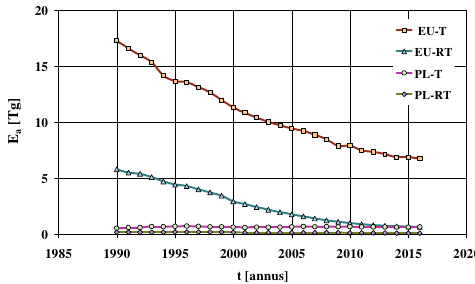
Fig. 5. Annual emission of particulate matter PM10: total in the Europe- an Union – EU-T, from motor vehicles in the European Union – EU-RT, Fig. 1. Annual emission of carbon monoxide: total in the European Union – EU-T, from motor vehicles in the European Union – EU-RT, total in Poland – PL-T, from motor vehicles in Poland – PL-RT in years 1990–2016